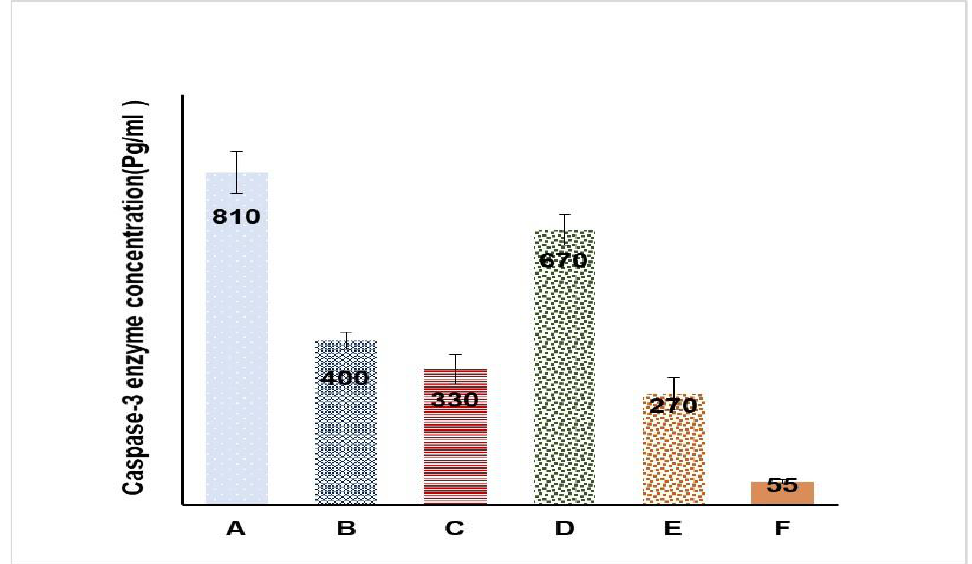
Figure 11. Caspase-3 enzyme concentrations in HSC3 cells treated with different formulations; data are presented as the mean ± SD ( n = 6). Results were statistically tested using the one-way ANOVA followed by the post-hoc Tukey HSD test.